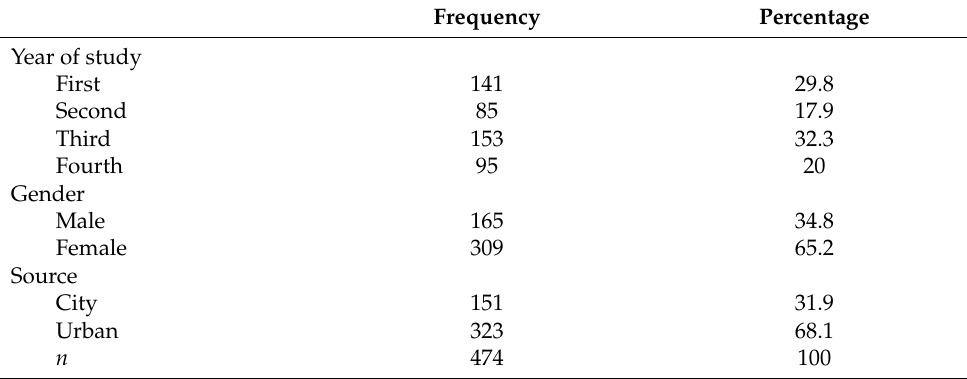
Table 1. Demographics of